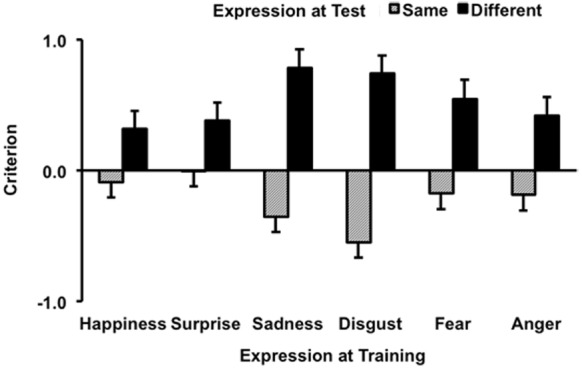
Criterion results as a function of trained and tested expression. Error bars represent one standard error above the means.